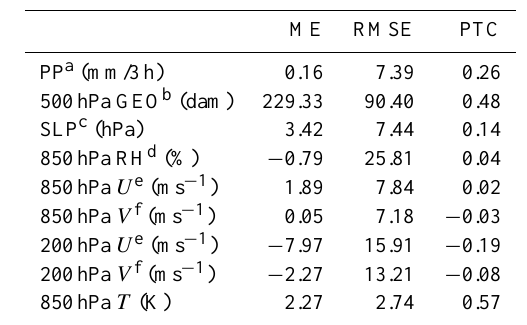
Table 5. Statistical measurements. Mean error (ME), root mean square error (RMSE) and pattern correlation coefficient (PTC) for the WRF simulations relative to observations.